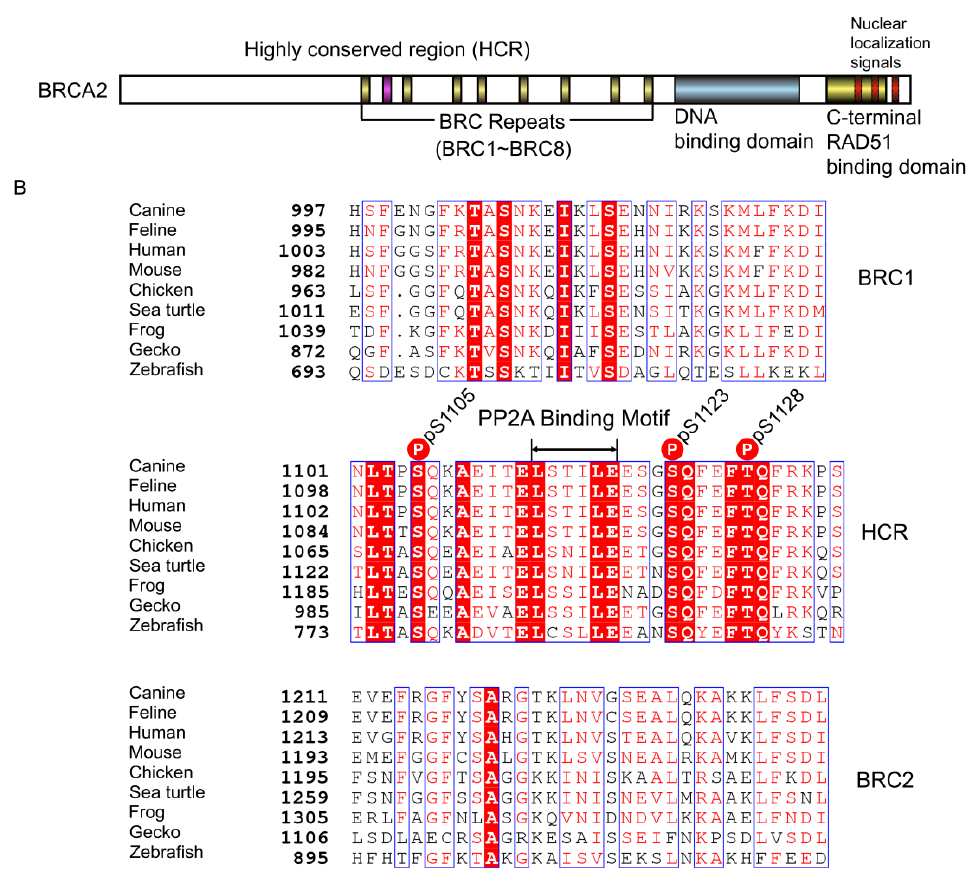
Figure 1. Location and alignment of the highly conserved region (HCR) between BRC repeat 1 (BRC1) and 2 (BRC2). ( A ) Schematic of the BRCA2 protein. Several major domains of BRCA2 were demonstrated, including the BRC repeats, DNA-binding domain, C-terminal RAD51-binding domain, and nuclear localization signals. BRCA2 interacts with RAD51 via the BRC repeats and C-terminal RAD51-binding domain. The HCR is located between BRC1 and BRC2 in canine BRCA2. ( B ) HCR, BRC1, and BRC2 alignment. Each canine, feline, human, mouse, chicken, sea turtle, frog, gecko, and zebrafish BRCA2 domain was aligned using ClustalW and ESPript (http://espript.ibcp.fr/, accessed on 19 October 2021). Identical residues are shown in red background; the conservative substitutions are grouped by blue boxes; red letters indicate similar residues according to the Risler matrix, and the remainder were shown in black [26]. The ATM and ATR phosphorylation sites and PP2A binding motif are marked in the figure [23]. Phosphorylation residue numbers are the amino acid numbers of the canine